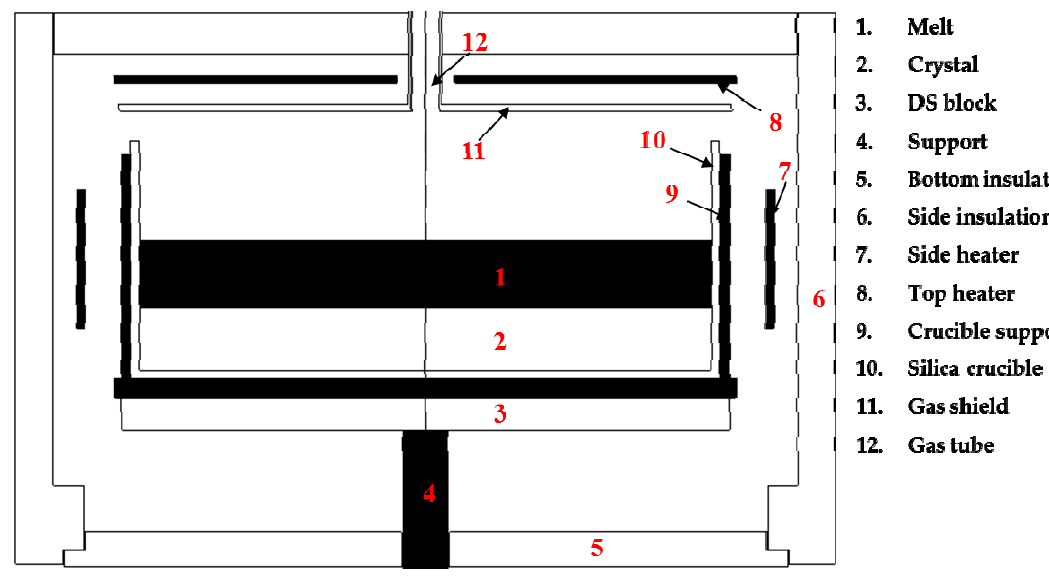
Figure 6. Configuration of the major components of an industrial DS system.